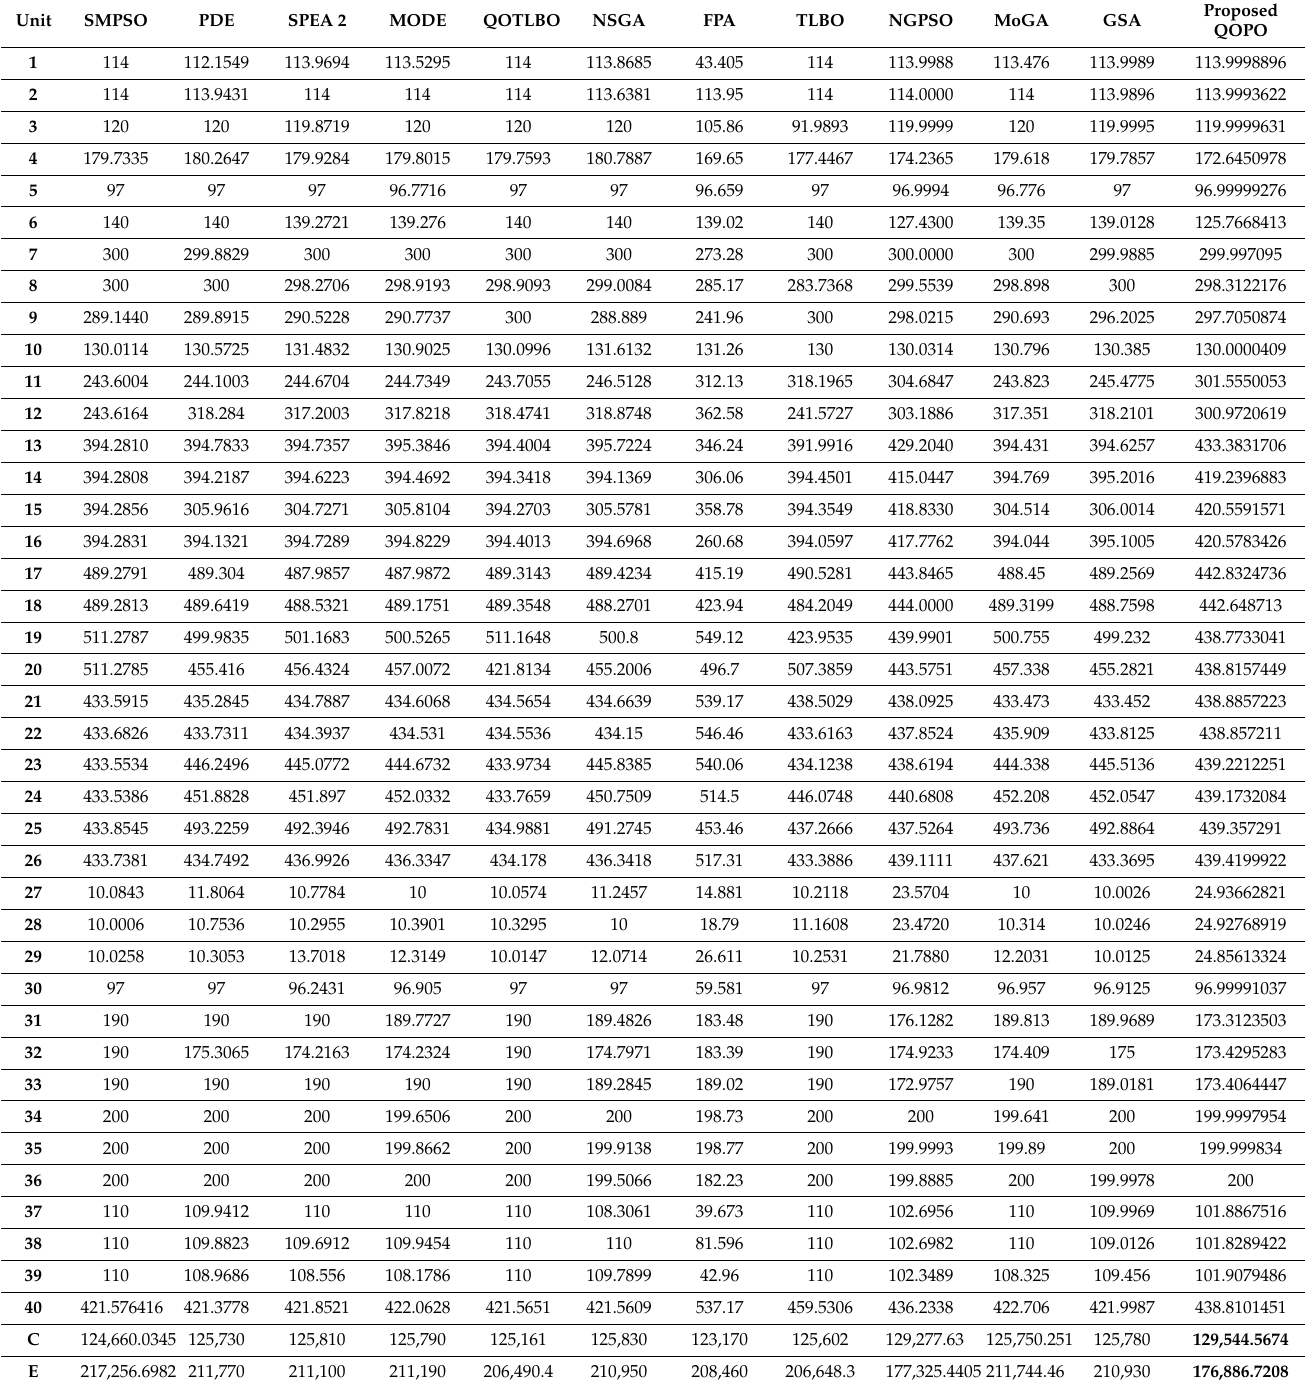
Table 13. Comparison of results of 40-unit system for the load demand of 10,500